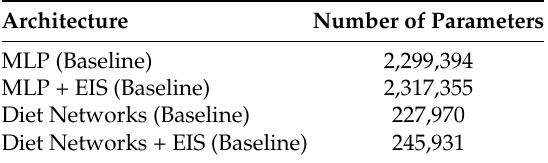
Table 1. Number of learnable parameters of each network